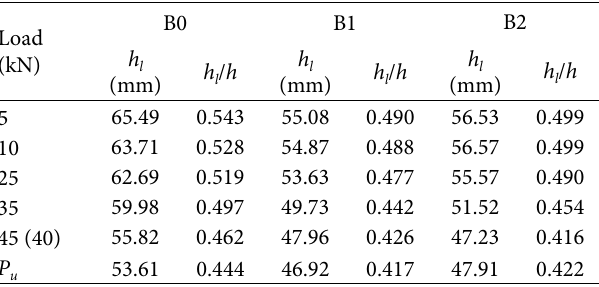
Table 5: Positions of neutral axis under different loads in the second